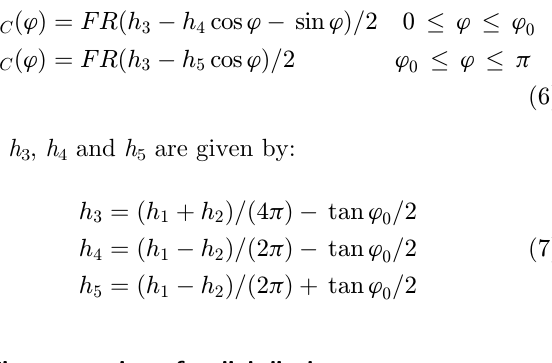
Fig. 3. Structure diagram of the ring under the action of three forces.